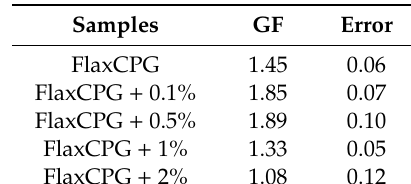
Table 3. Average GF values obtained for each sample.